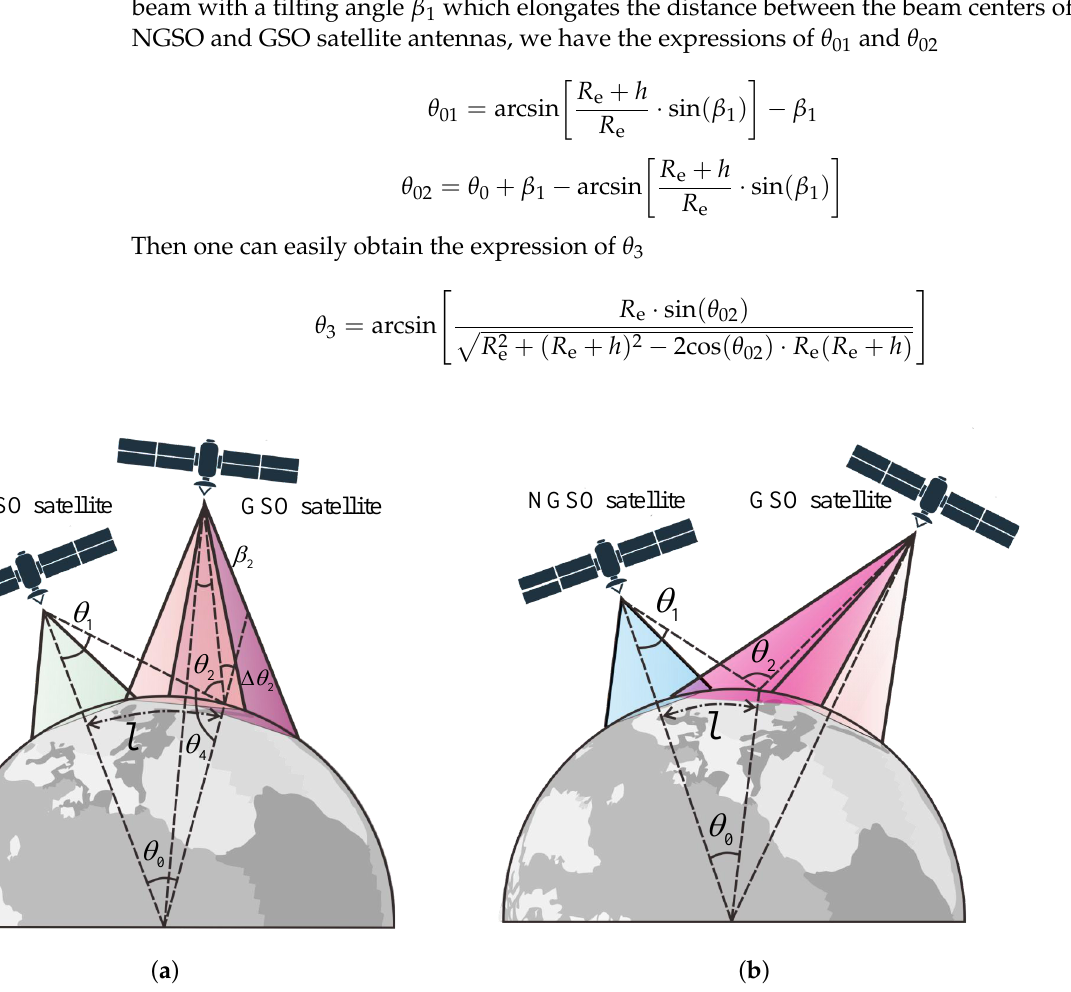
Figure 5. The downlink scenarios where GSO satellite beams have tilting angle rendering the beam center farther away or closer to the other center. ( a ) Pointing of GSO satellite beams with tilting angle β 2 making it farther away from the beam center of NGSO satellite; ( b ) Pointing of GSO satellite beams with tilting angle β 2 making it closer to the beam center of NGSO